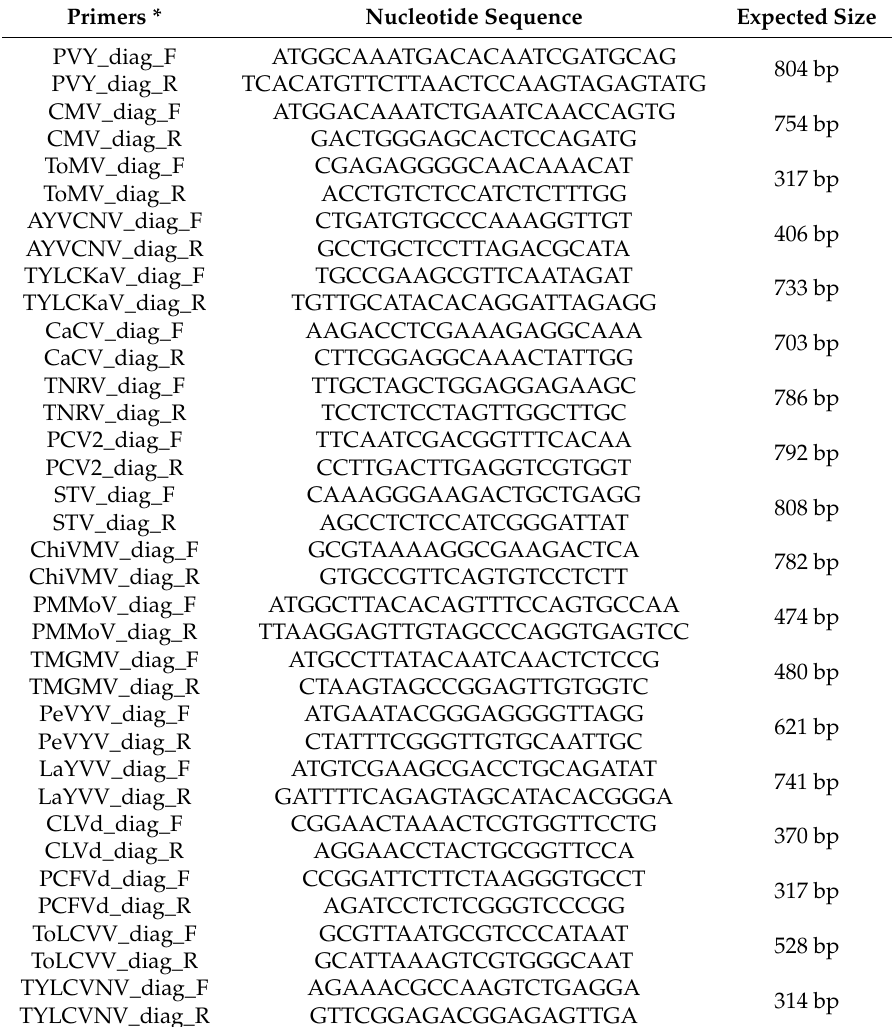
Table 1. Information of Primer Pairs Used for RT-PCR to Validate the RNA-Seq Results. Primers